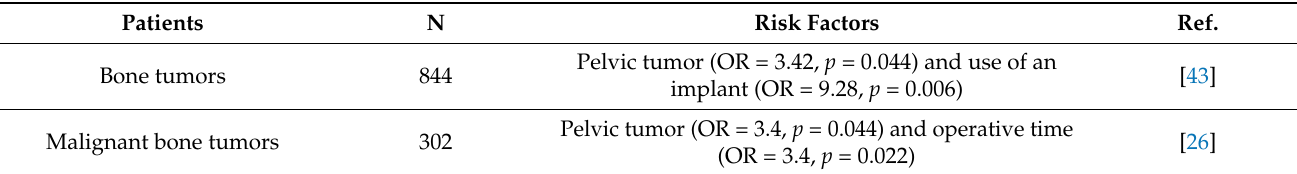
Table 2. Risk factors for SSI in bone tumor